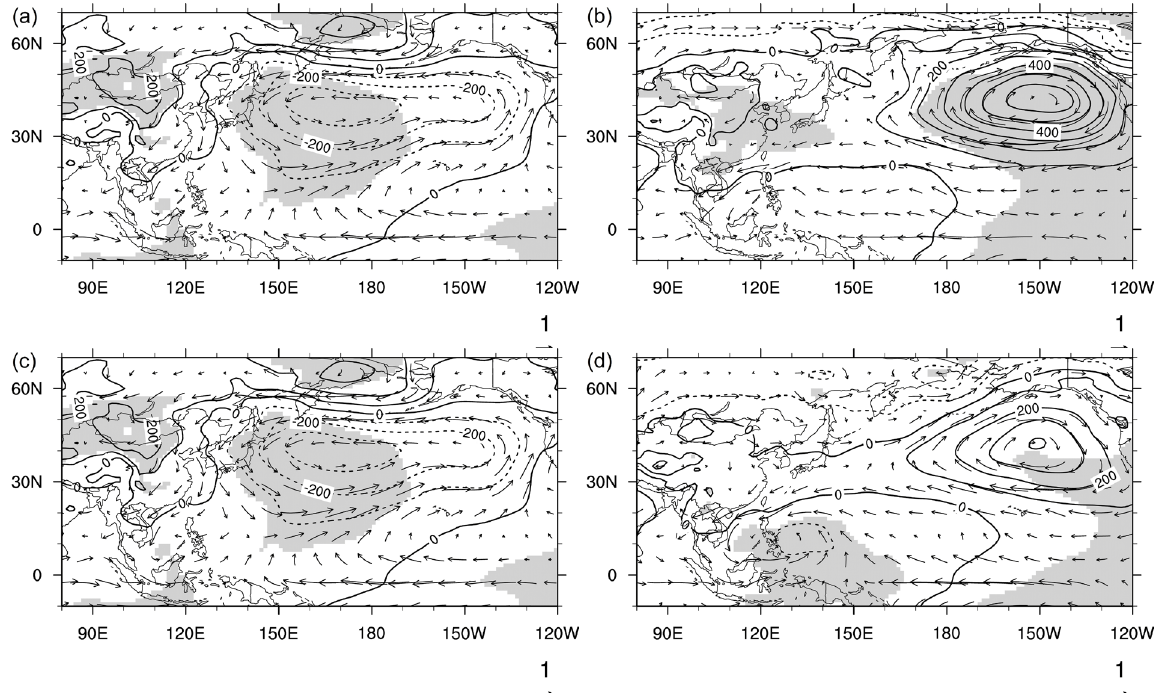
Figure 5. Spatial patterns of composite differences between positive and negative phases -related part and ( b ) the I -unrelated to PC1pri; ( c ) and ( d ) are the same as of ( a ) the I Xu Xu (a) and (b), but for the PC1sec. The vector and contour line are the differences of wind (meters per second) and sea level pressure (hectopascals), respectively, and the shading contour is the 0.05 significance